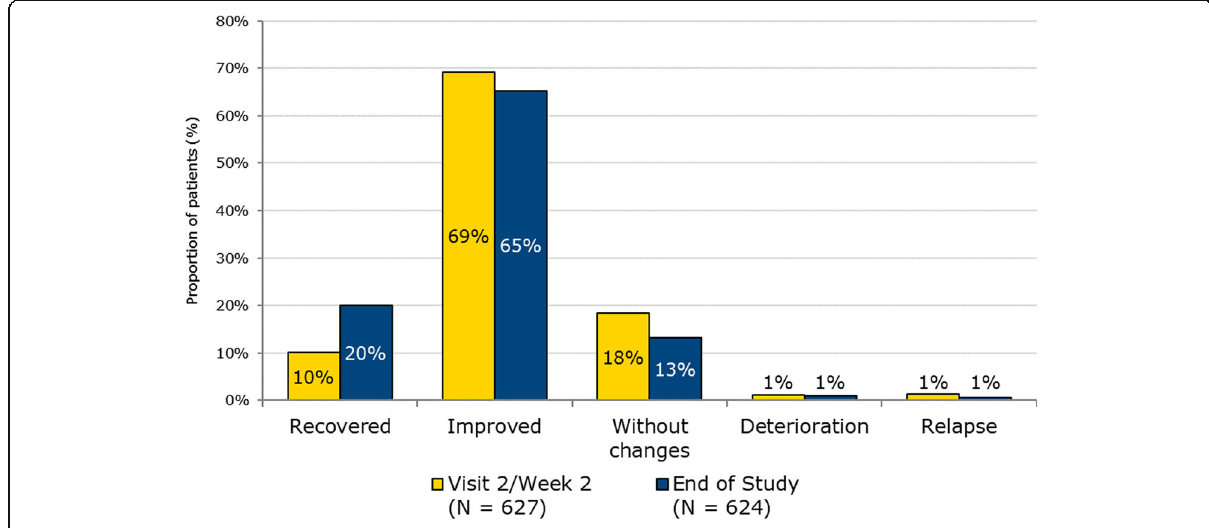
Fig. 6 Urinary Disease Outcomes (Safety Set, patients with available outcome data)